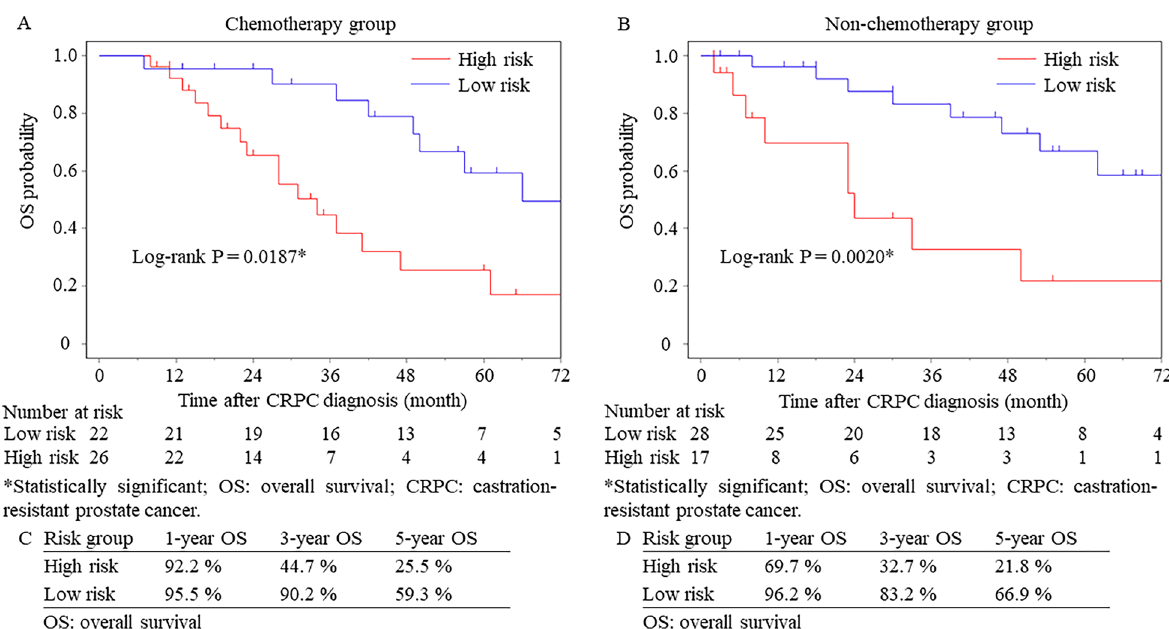
Figure 3. Kaplan–Meier curves for the patients ( A ) with and ( B ) without chemotherapy treatment. The overall survival rates for the patients treated ( C ) with and ( D ) without chemotherapy